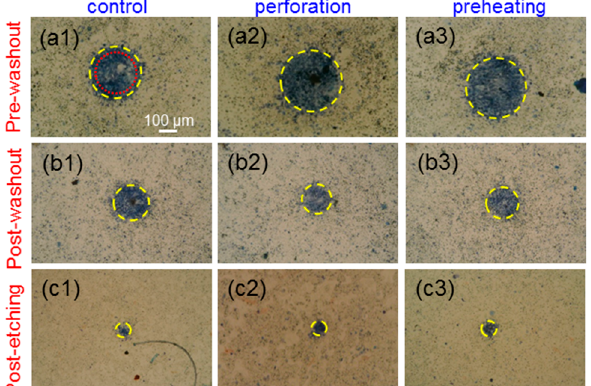
Figure 5. ( a1 – a3 ): Images of trypan blue stained cells incubated with NRI + AlPcS under the pre-washout condition in the cases of no pre-treatment (control), perforation, and preheating, respectively, when cell samples were illuminated by the focused 1064-nm cw laser. ( b1 – b3 ) and ( c1 – c3 ) show the images similar to parts ( a1 – a3 ), respectively, under the post-washout and post-etching condition, respectively.